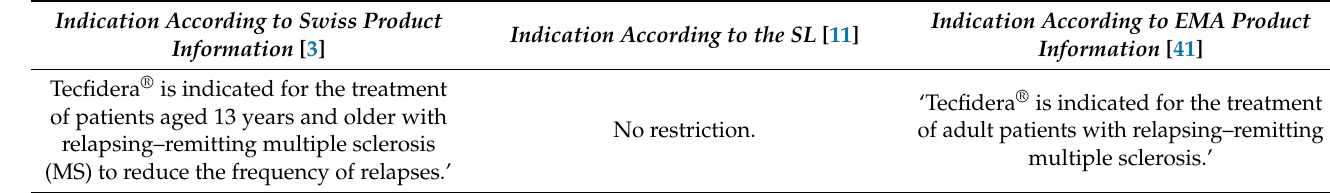
Table 10. Dimethyl fumarate (Tecfidera ®